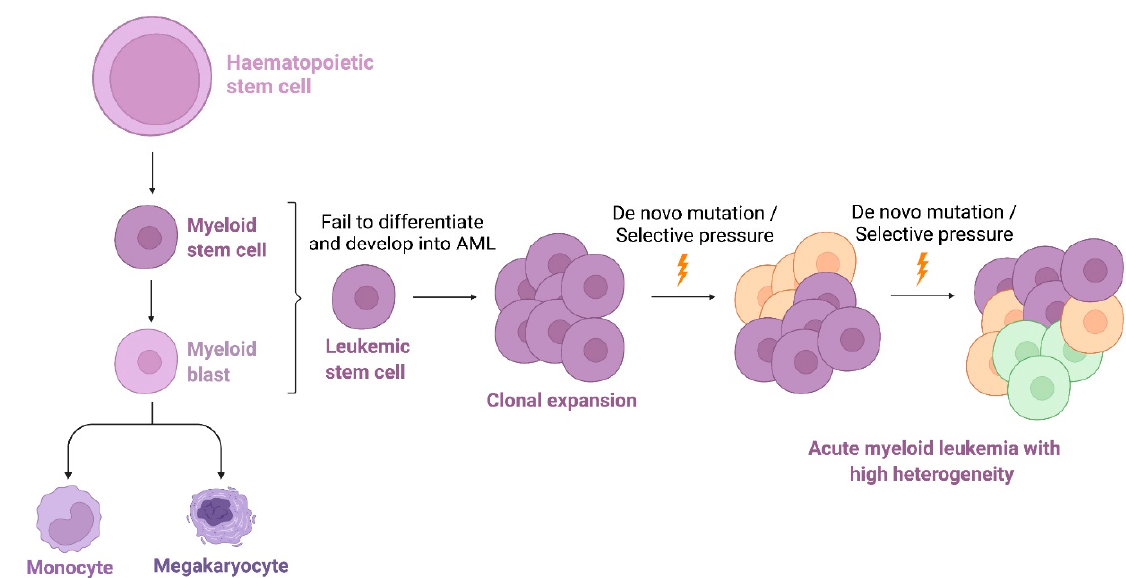
Figure 1. Acute myeloid leukemia (AML). AML is originated from malignant haematopoietic stem cell and is characterized by abnormal clonal expansion and aberrant differentiation of immature clonal myeloid cells. AML progresses with the acquisition of new genetic and/or epigenetic abnor- malities in response to chemotherapy and displays substantial heterogeneity. This figure is created in BioRender.com (Available online https://biorender.com/, last accessed on 25 February 2022).